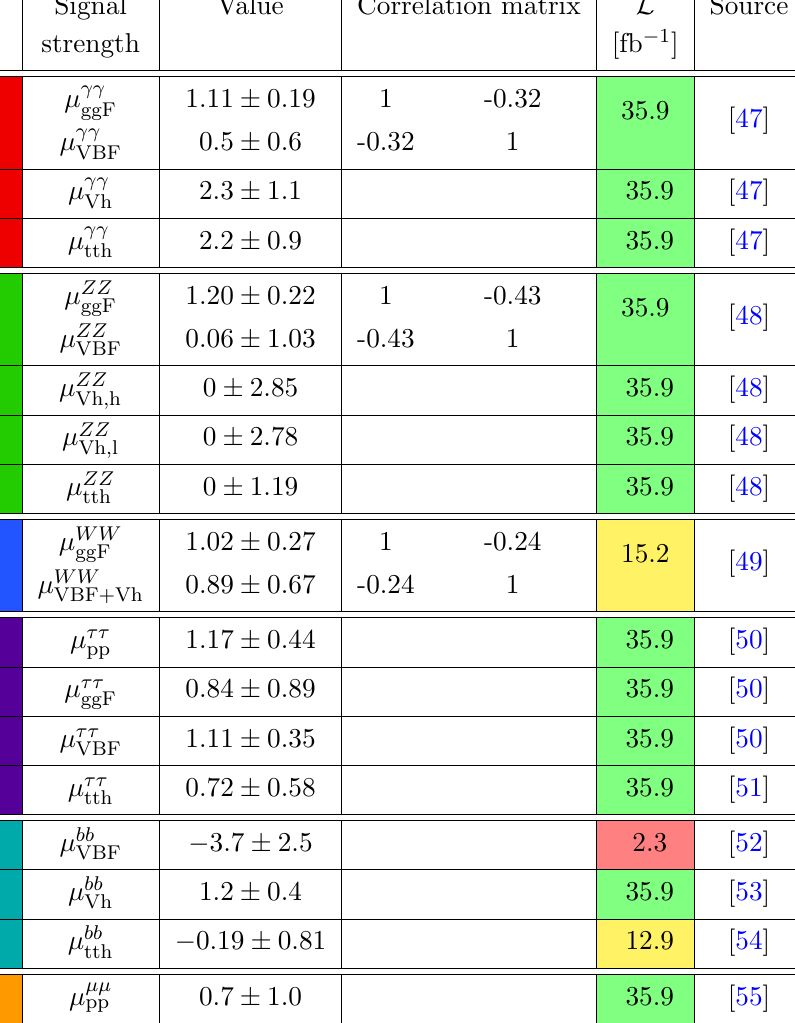
Table 4 . Run 2 h signal strengths measured by CMS. The colours in the (cid:12)rst column correspond to the ones in (cid:12)gures 1 and 2, the ones in the (cid:12)fth column to the amount of underlying data like